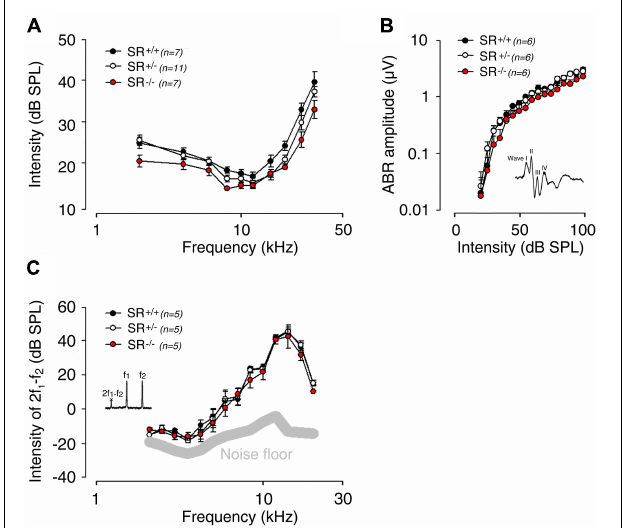
FIGURE 3 | Genetic deletion of serine racemase and hearing in adult mice. (A) Auditory brainstem response (ABR) audiograms for SR − / − ( n = 7), SR + / − ( n = 11) and SR + / + ( n = 7) mice obtained by plotting ABR thresholds as a function of the stimulation frequency (2, 4, 6.3, 8, 10, 12.5, 16, 20, 24, and 32 kHz tone bursts). Compare to SR + / + (black circles) mice, SR − / − (red circles) and SR + / − (white circles) mice showed normal sound evoked-response at any stimulating frequency and intensity. (B) Normal input-output functions of the ABR wave I evoked by 16 kHz tone-bursts from 0 to 100 dB SPL in SR − / − ( n = 6), SR + / + ( n = 6) and SR + / − ( n = 6) mice. (C) Recordings of distortion product otoacoustic emissions (2f 1 -f 2 ) reflect the cochlear non-linearity in outer hair cell function. No significant change was measured between SR − / − ( n = 5), SR + / + ( n = 5) and SR + / − ( n = 5) mice. The thick gray line indicates the background noise level of the recording system in the absence of sound. Values are mean ± SE, and n indicates the number of animals tested. There were no statistically significant differences between